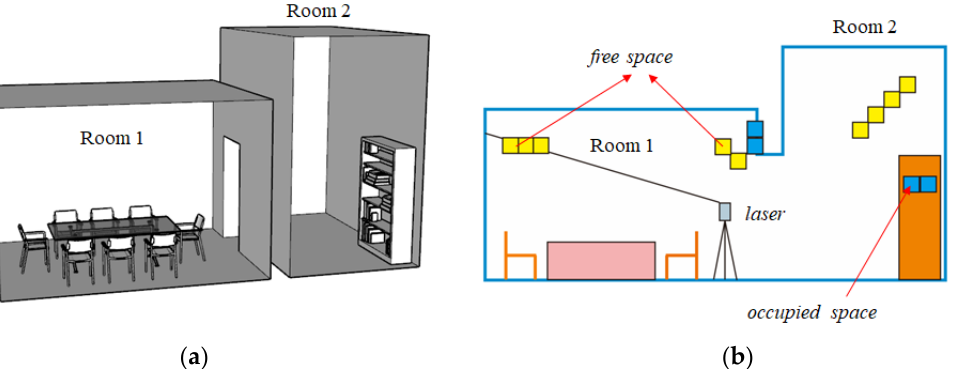
Figure 2. Illustration of an indoor space: ( a ) two rooms are separated by a door; ( b ) the voxels in yellow are free spaces, and the voxels in blue are occupied spaces.